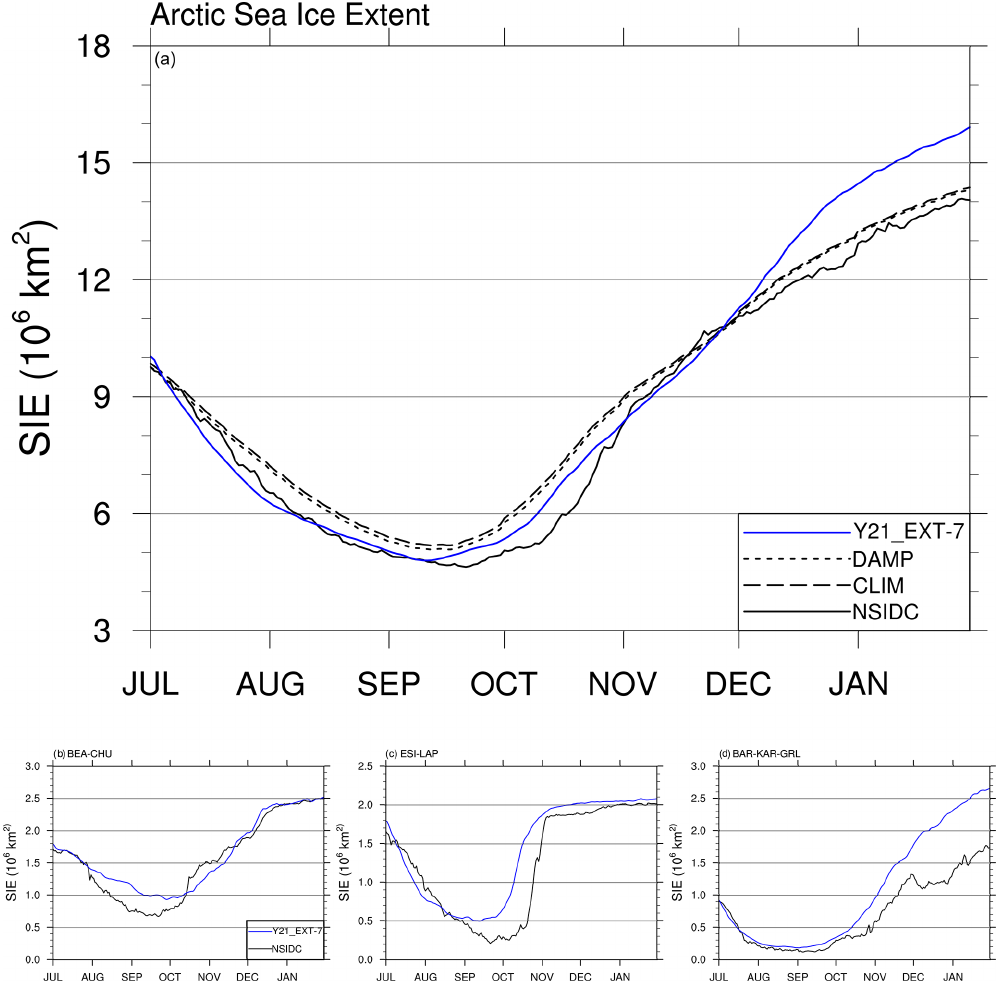
Figure 12. Same as Fig. 4 but for